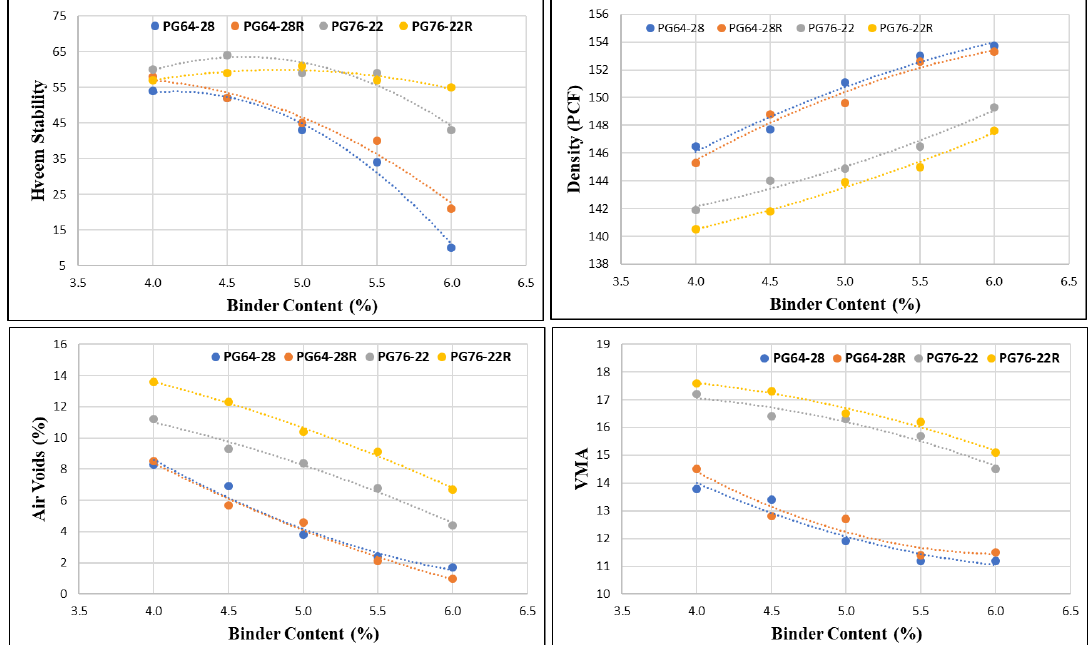
Figure 2. Mix design properties of four binder specimens.